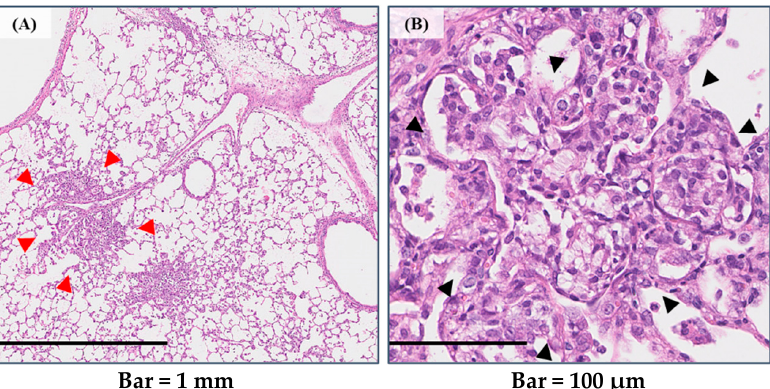
Figure 9. Distribution of lung inflammation in the exposed group. Peribronchiolar pulmonary inflammation was found (red arrow heads), and the alveolar spaces were filled with inflammatory cells (black arrow heads) (in HMW PAA-exposure group). ( A ) Low-power field; ( B ) high-power field. (Internal scale bar = 1 mm for ( A ) and 100 µm for ( B )).